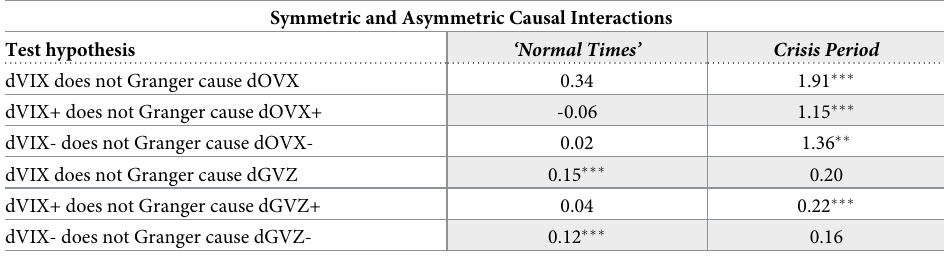
Table 5. Causality tests, COVID-19 crisis